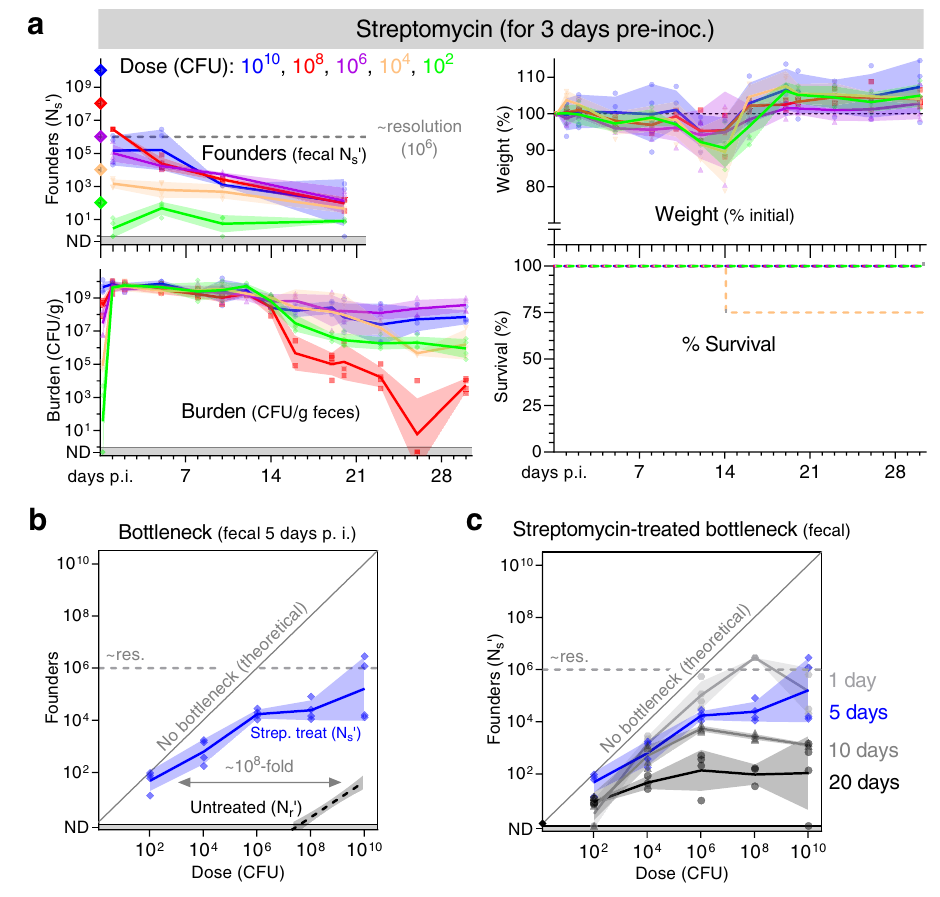
Fig. 6 | Streptomycin treatment ablates most of the bottleneck preventing C. rodentium colonization. The microbiota of conventional C57BL/6J mice was reduced by treatment with the antibiotic streptomycin for the 3 days prior to inoculation with a streptomycin resistant library of STAMP-CR69K. a Founding populationandbacterialburdenmonitoredinthefeces,and( b , c )thebottleneckto colonization measured by comparing dose and founders (geometric means and